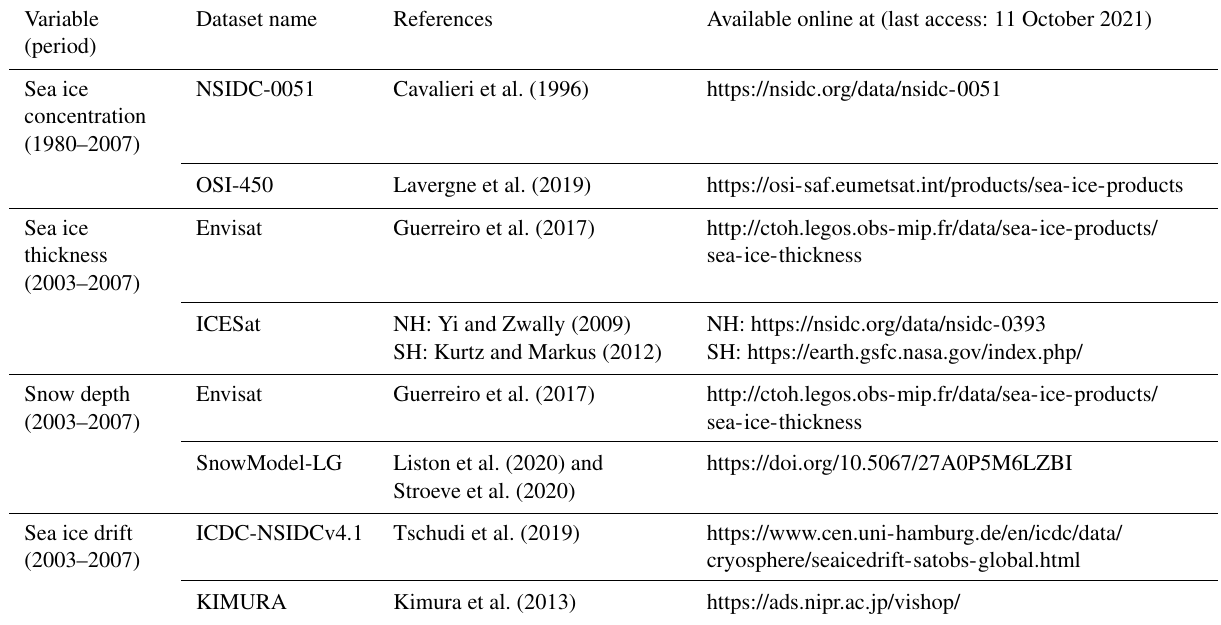
Table 3. Observational references used to compare with model